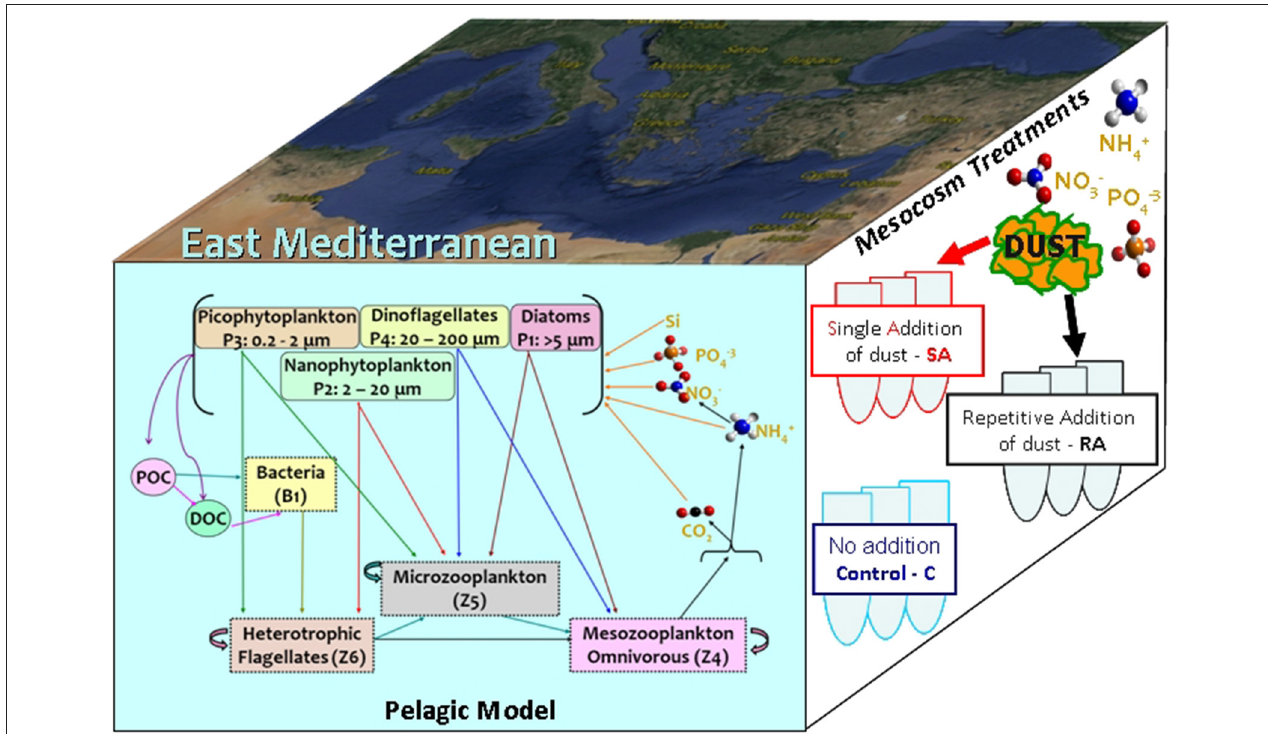
FIGURE 1 | Model schematic indicating the plankton food web interactions. A schematic of the mesocosm treatments and the study area are also shown.